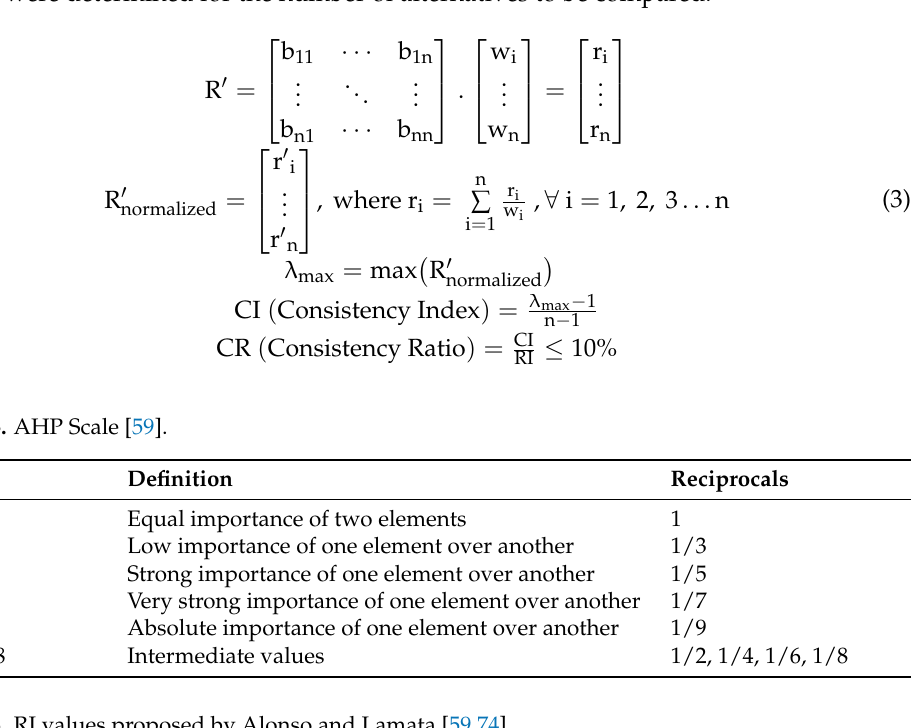
Table 6. RI values proposed by Alonso and Lamata